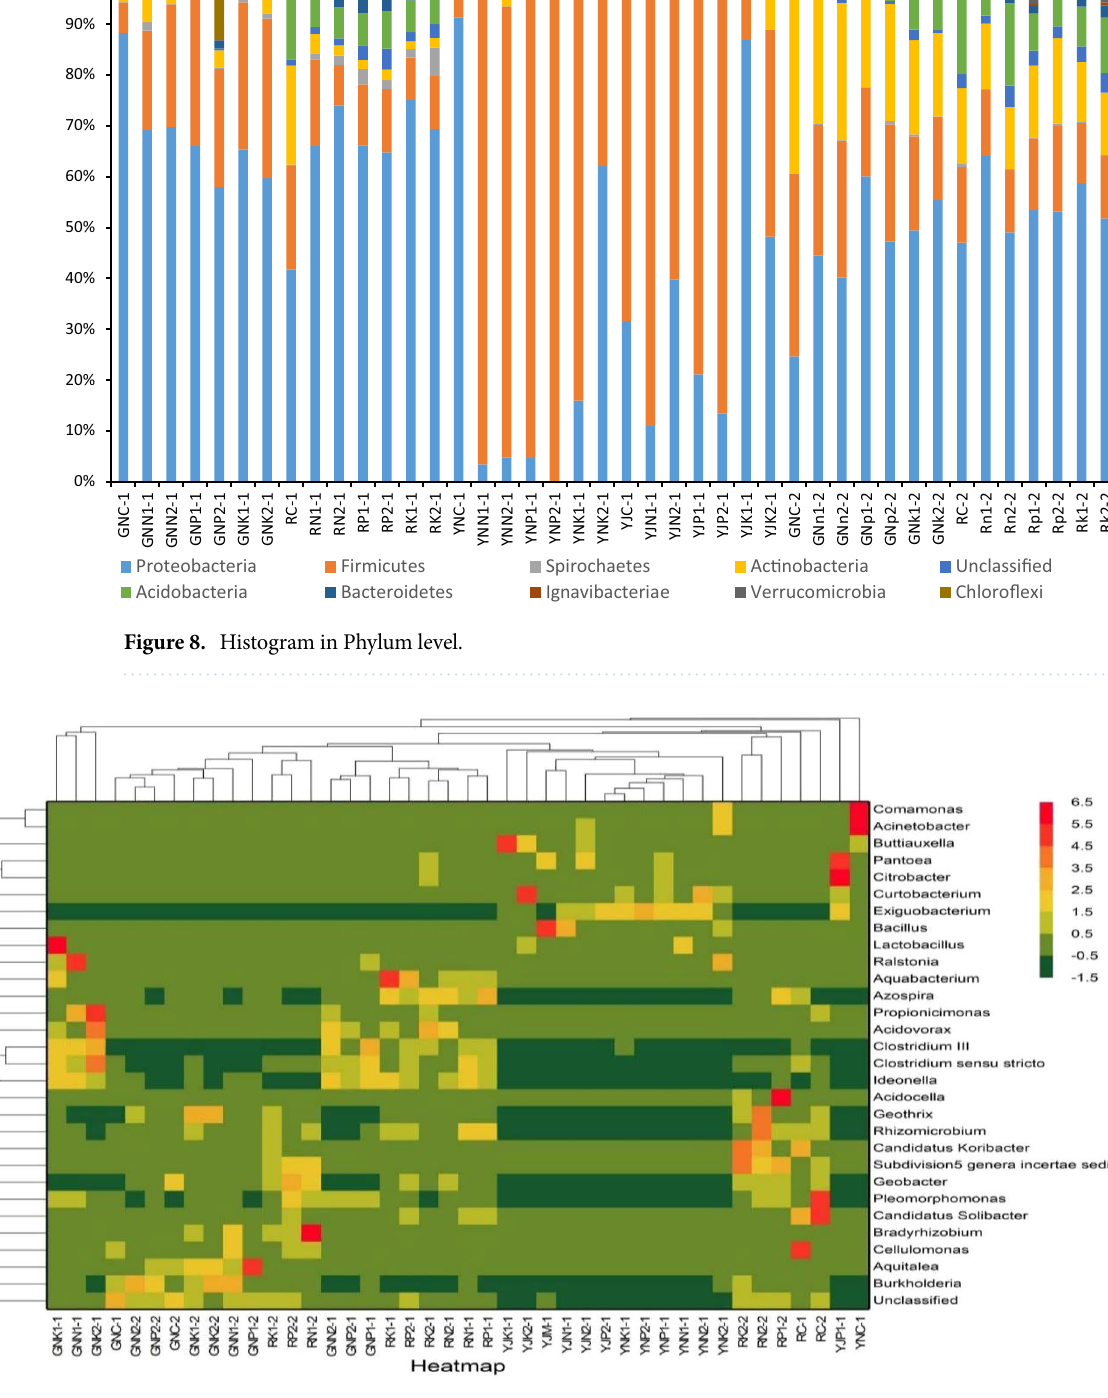
Figure 9. Clustering heat map in Genus